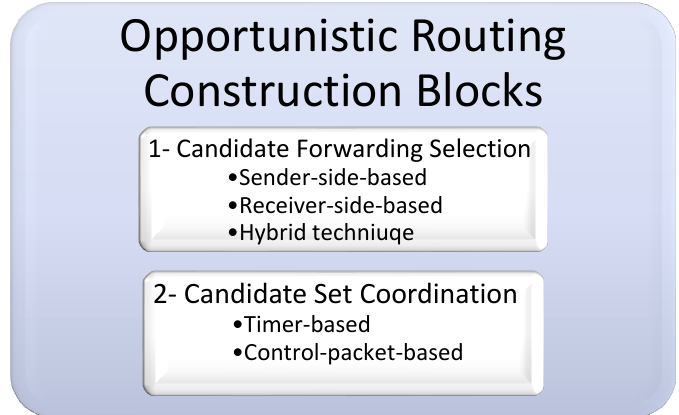
Figure 3. Opportunistic routing building blocks.